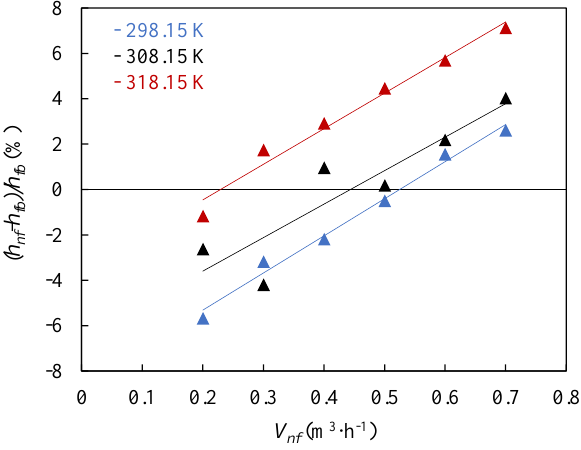
Figure 6. Enhancement of the convection heat transfer coefficient of 0.25 wt % nanofluid, h nf , regarding